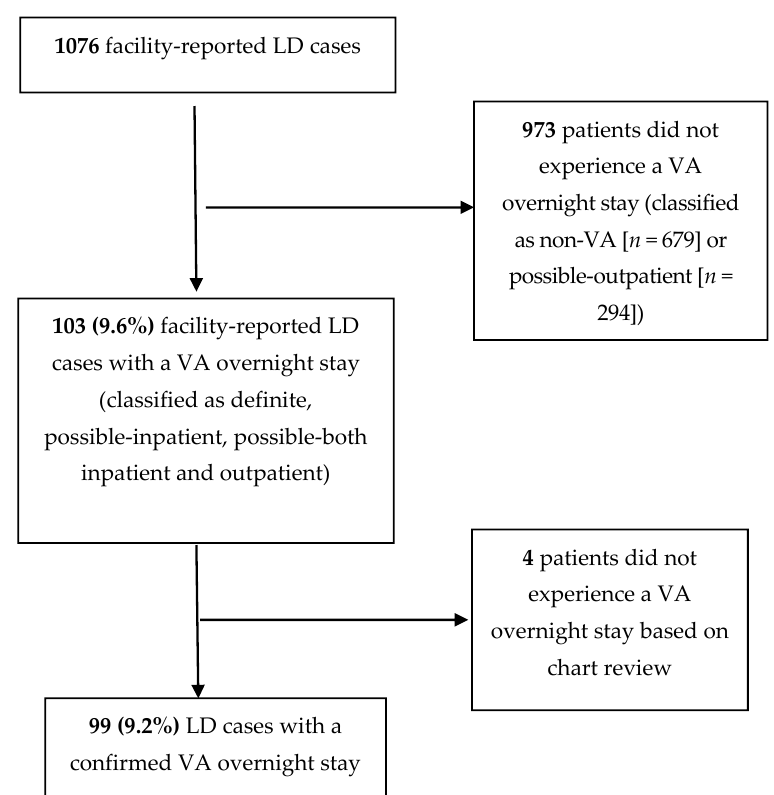
Figure 1. Study population selection from patients entered into the VA LD Case Report database between September 2012 through July 2019 (Abbreviations: VA, Department of Veterans Affairs; LD, Legionella Disease).